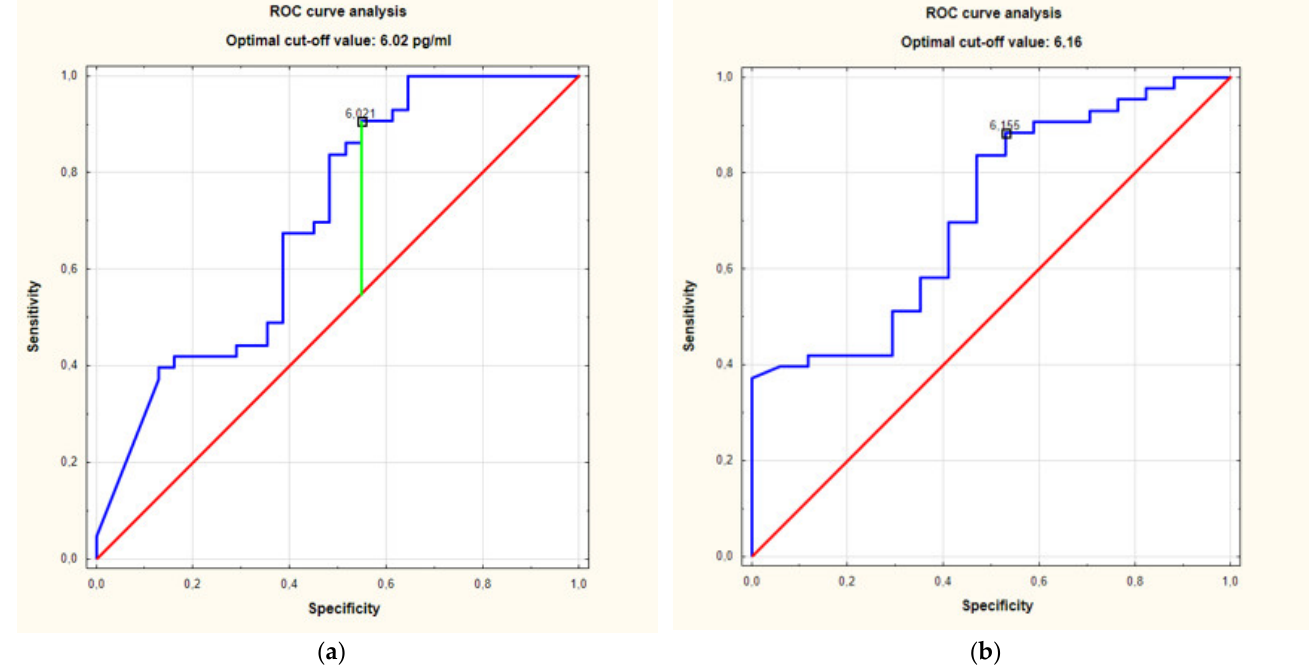
Figure 2. ( a ). ROC curve analysis of relationship between serum concentrations of S100A4 in individuals with HS in stage Hurley II + III and controls. Receiver operating characteristics (ROC) curves analysis showed area under the curve (AUC) of 0.7. (95%CI for AUC: 0.58–0.83) ( p = 0.0014). ( b ). ROC curve analysis of relationship between serum concentrations of S100A4 in individuals with HS Hurley II + III and Hurley I. Receiver operating characteristics (ROC) curves analysis showed area under the curve (AUC) of 0.72 (95%CI for AUC: 0.58–0.86) ( p = 0.0022).